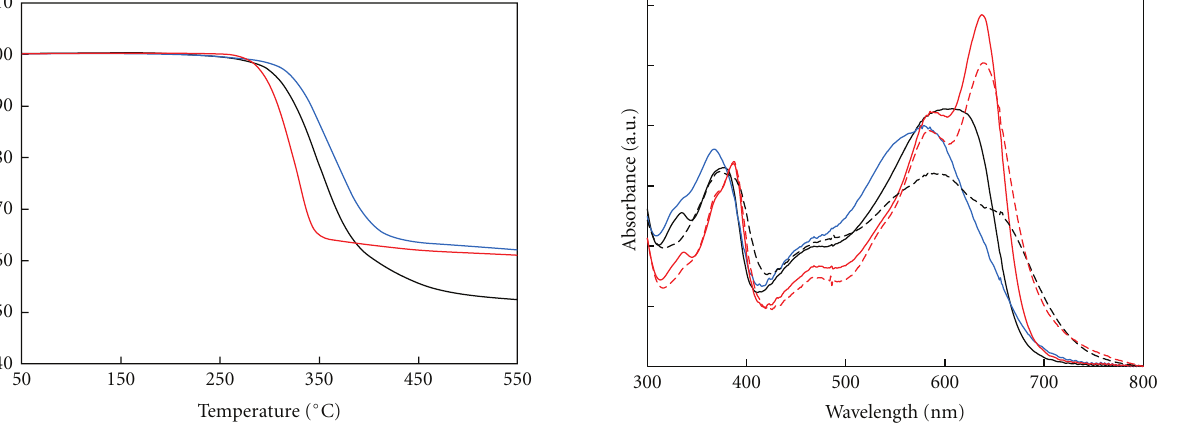
Figure 1: TGA curves of P1 (black), P2 (blue), and P3 (red) under argon at a heating rate of 5 ◦ C/min.